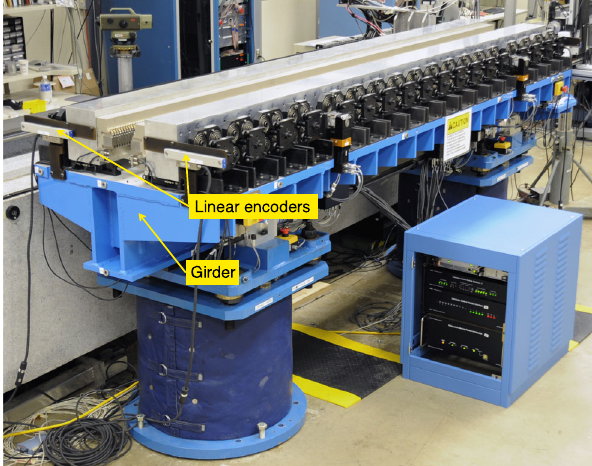
FIG. 1. LCLS-II horizontal gap vertically polarizing undulator (HGVPU).